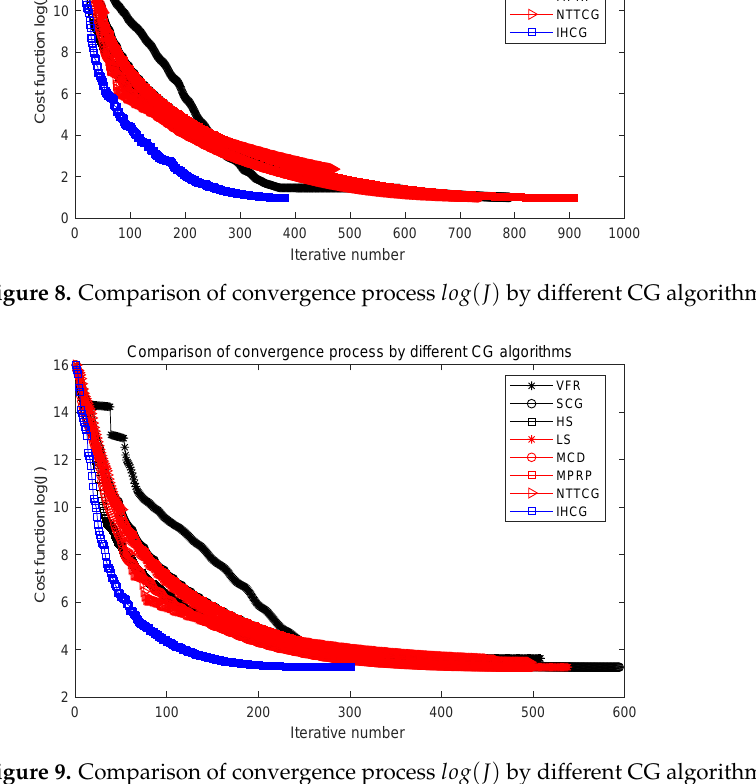
Figure 9. Comparison of convergence process log ( J ) by different CG algorithms ( δ = 0.03).